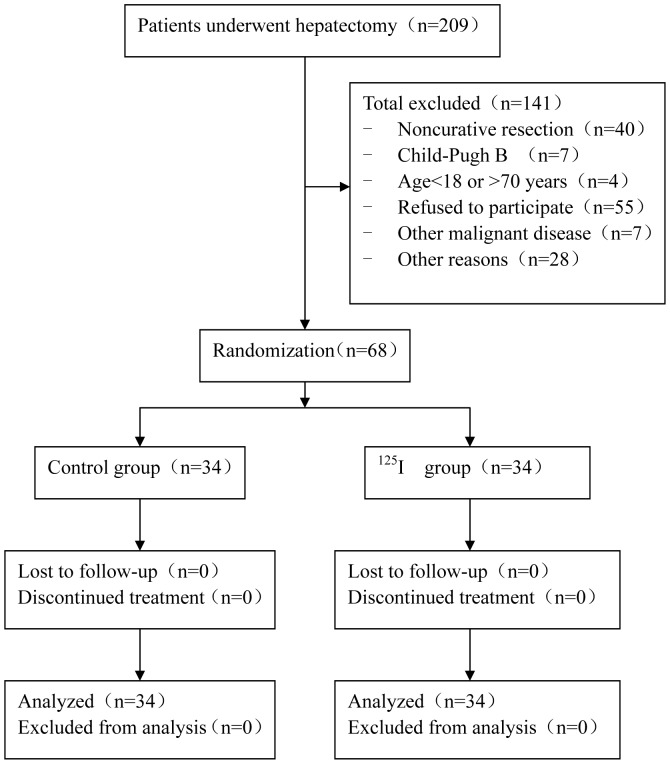
A flow chart of the trial.